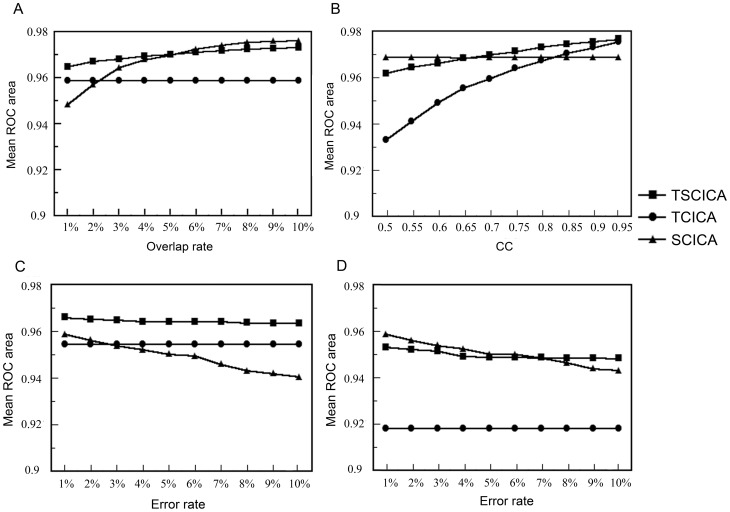
Results of the robustness to spatial overlap rate, temporal accuracy and spatial error rate.(A) The variation of the mean ROC area with overlap rates for TSCICA, TCICA and SCICA. (B) The variation of the mean ROC area with temporal reference for TSCICA, TCICA and SCICA. CC represents the correlation coefficient between the temporal reference and the true time course. (C) The variation of the mean ROC area with error rate in the case of a high temporal accuracy (CC = 0.8) for TSCICA, TCICA and SCICA. (D) The variation of the mean ROC area with error rate in the case of a low temporal correlation(CC = 0.6) for TSCICA, TCICA and SCICA. CC represents the correlation coefficient between the temporal reference and the true time course.